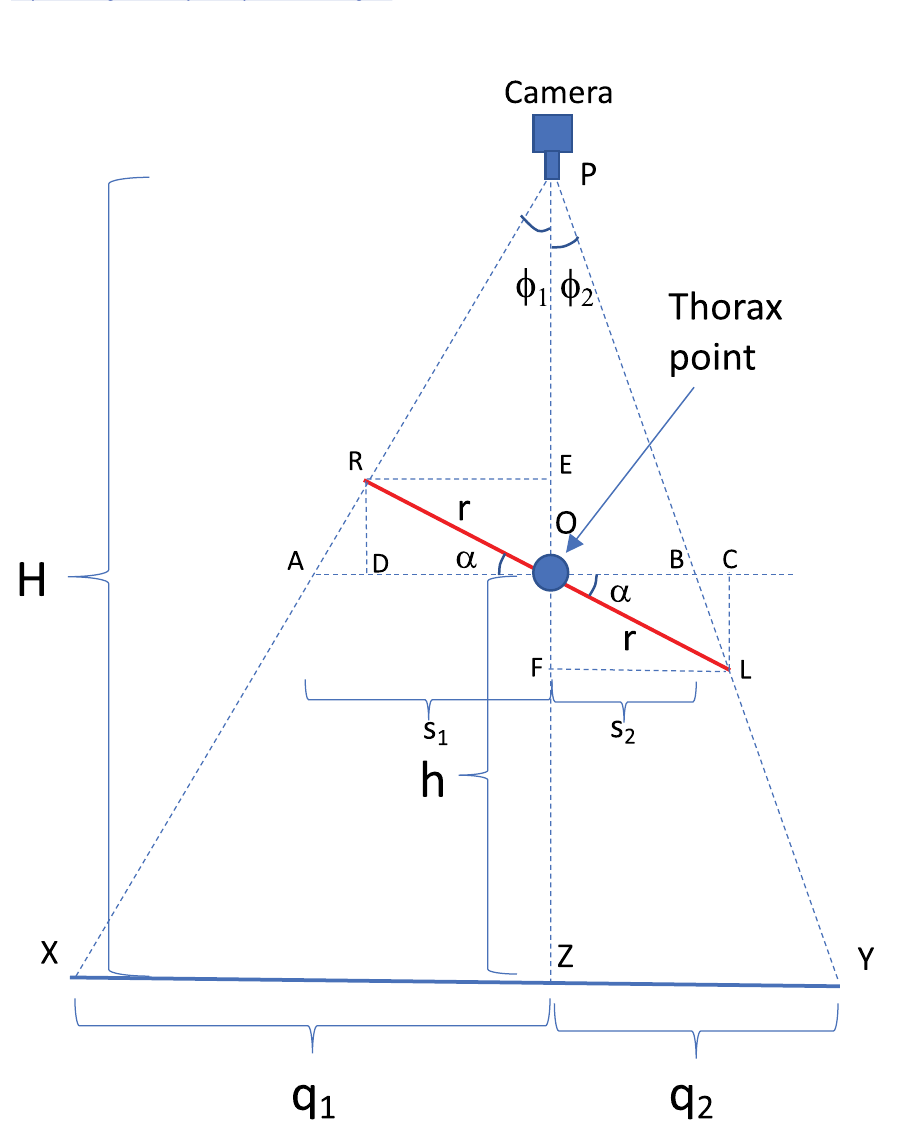
Fig 10. Calculation of height and roll angle. Illustration of calculation of bird height (h) and roll angle ( α ) for a simplified case in which the midpoint of the wingspan is directly below the camera’s optical axis. The known wingspan of the bird is 2r, and the camera is at a known height H above the